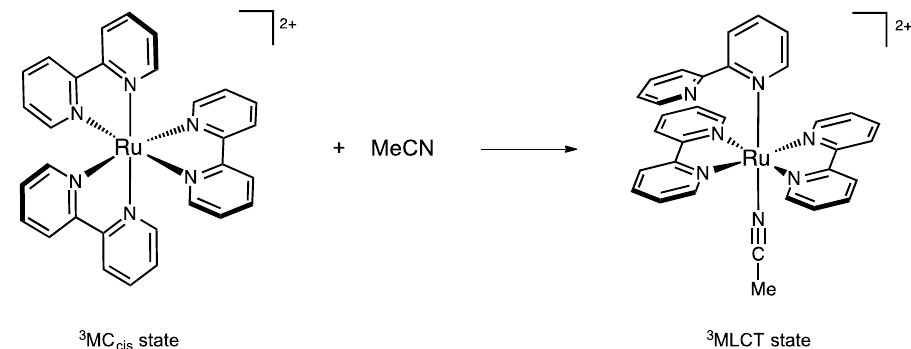
Figure 1. Structures of 3 MC trans and 3 MC cis in Ru(bpy) 32+ (H atoms not shown).